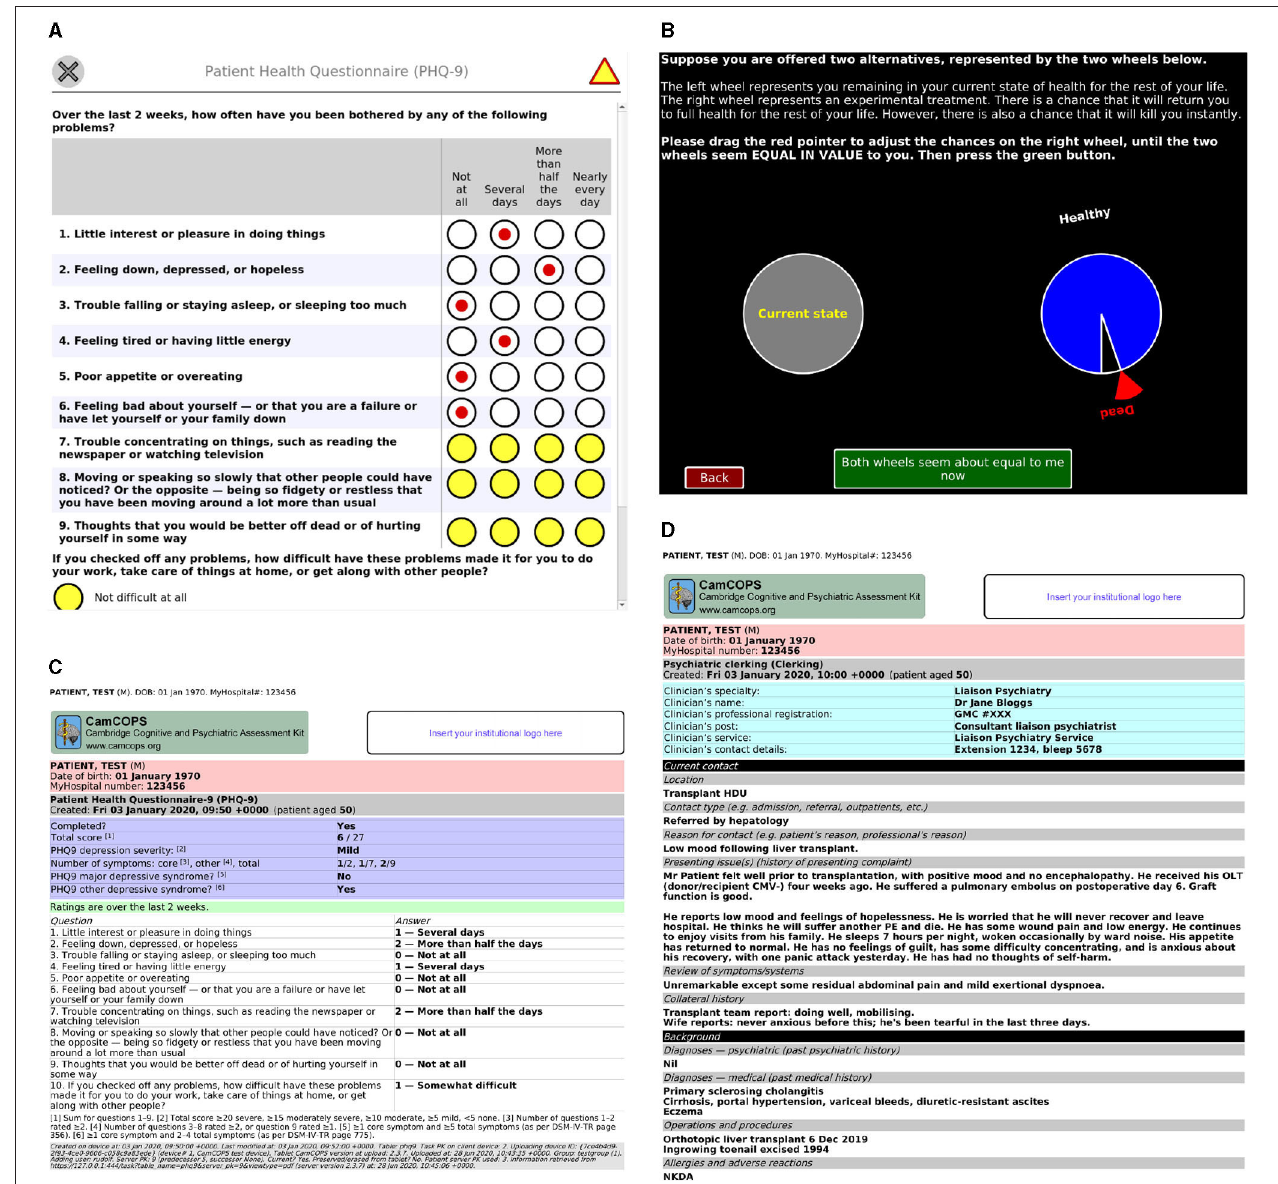
FIGURE 3 | Task examples. (A) The PHQ-9 task, a simple questionnaire. Yellow is used to highlight mandatory fields that are not yet complete. (B) A simple graphical task: a quality-of-life standard gamble. (C) The PDF automatically generated by the server for the task in (A) after it was subsequently completed. (D) A server view of a task capturing text from an initial psychiatric assessment. All data are entirely fictional. CMV, cytomegalovirus; GMC, UK General Medical Council; HDU, high dependency unit; NKDA, no known drug allergies; OLT, orthotopic liver transplant; PE, pulmonary